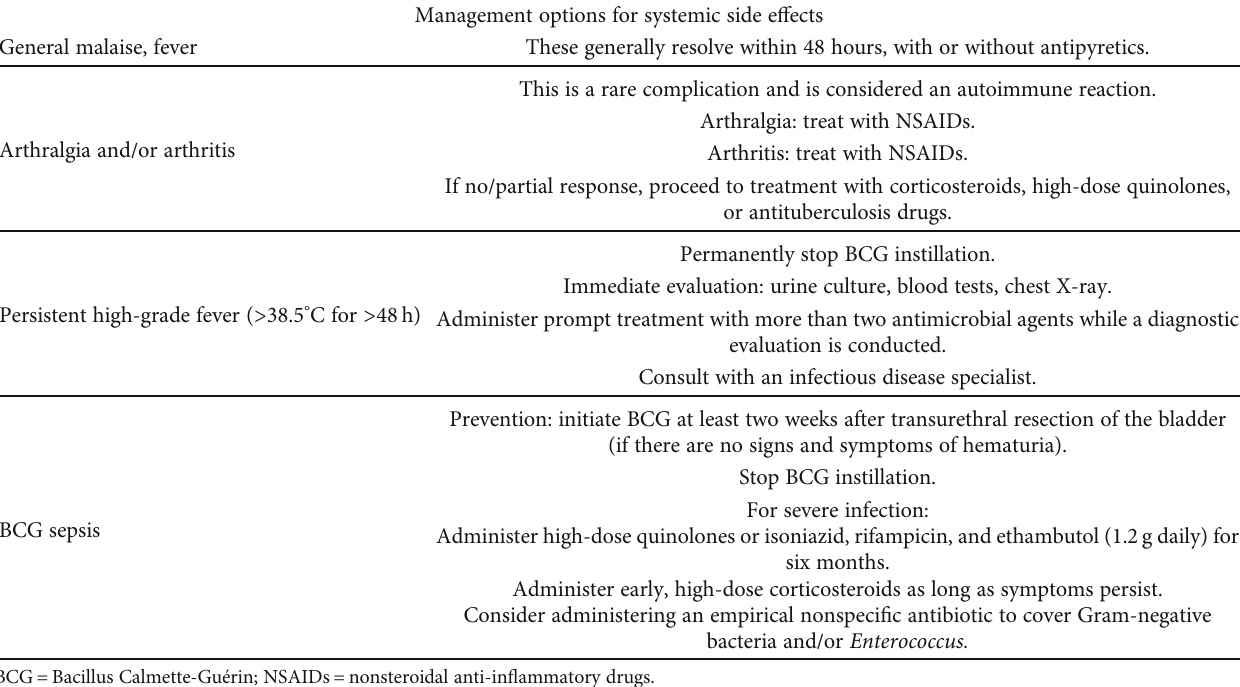
Symptomatic granulomatous prostatitis